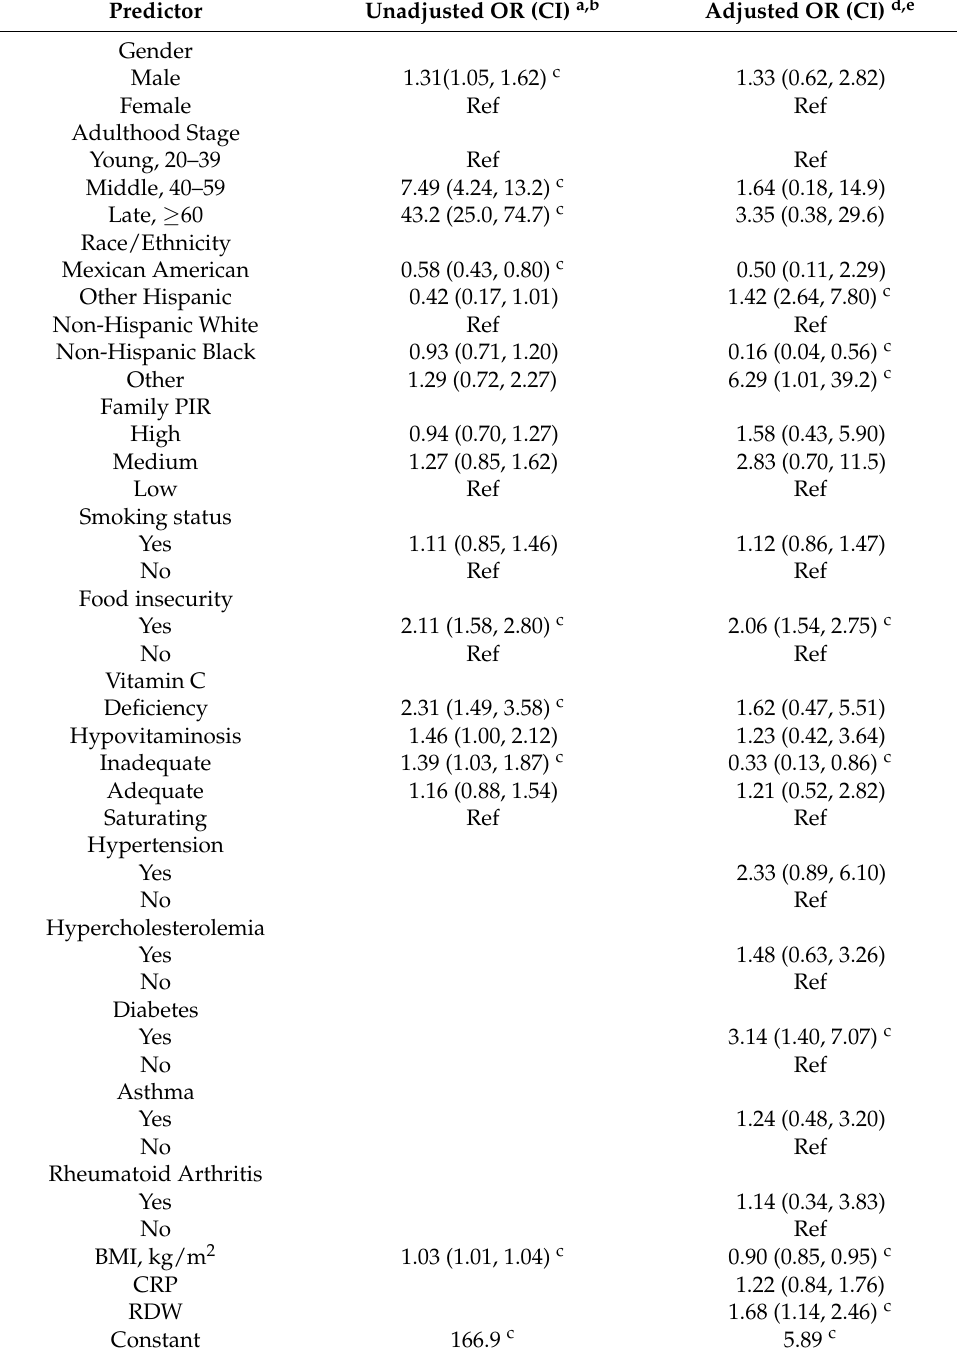
Abbreviations: BMI, body mass index; CAD, coronary artery disease; CRP, C-reactive protein; OR, odds ratio; PIR, poverty to income ratio; RDW, red cell distribution width; Ref, reference. a Model (likelihood ratio) χ 2 =